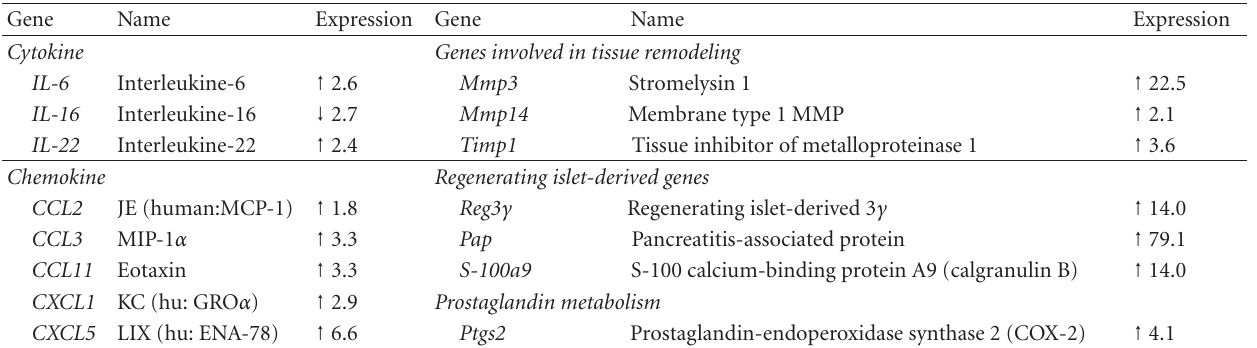
Table 2: Di ff erentially expressed genes in acute phase of DSS colitis that had been previously associated with human IBD [34].